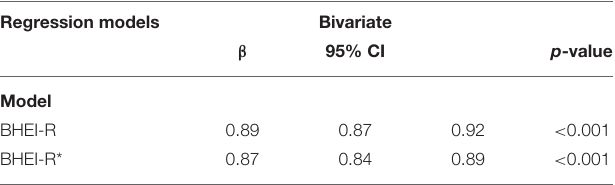
TABLE 4 | Association between Cardiovascular Health Diet Index and overall dietary quality. ELSA-Brasil, 2008–2010. Regression